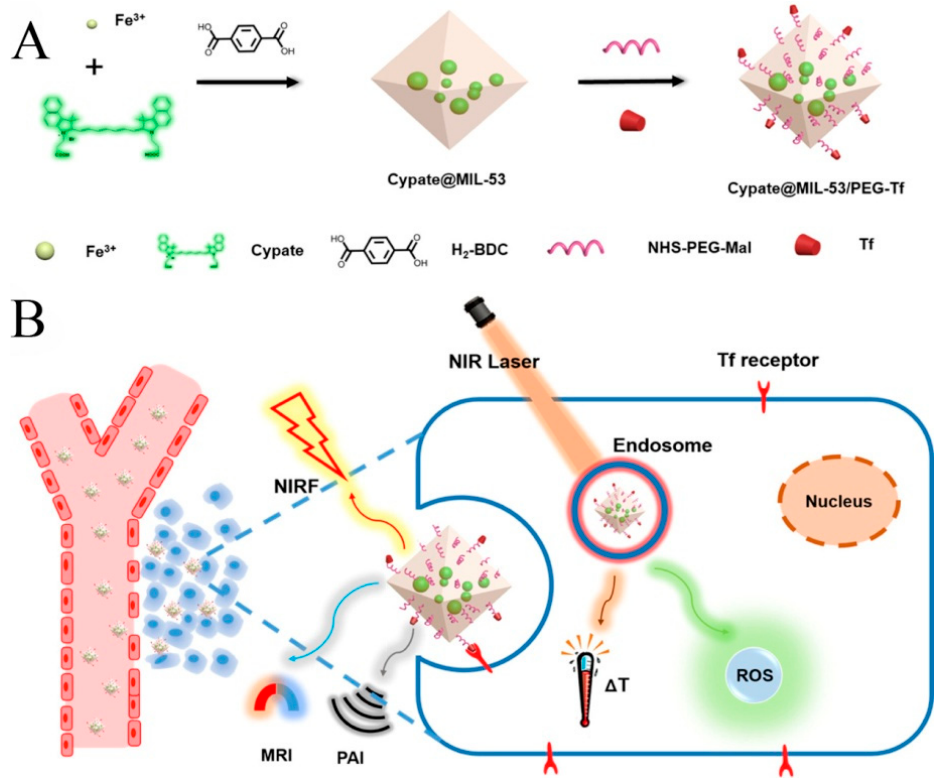
Figure 9. ( A ) the preparation of Cypate@MIL-53/PEG-Transferrin MOF composite and ( B ) its bioapplication for PDT and PTT. Reprinted with permission from Ref. [70]. Copyright 2019, American Chemical Society.